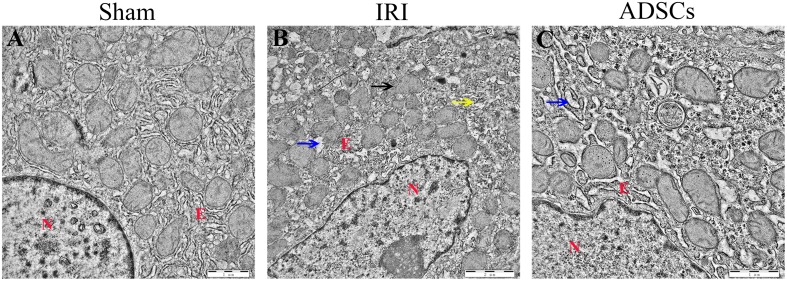
Ultrastructural changes in the liver post-IR. TEM micrographs of the liver in (A) sham-operated, (B) IRI, and (C) ADSCs groups. The blue arrow indicates ER swelling, the yellow arrow indicates the disordered structure of ER, and the black arrow indicates the mitochondrial swelling and the disappearance of mitochondrial ridge. N, nuclei; E, endoplasmic reticulum.